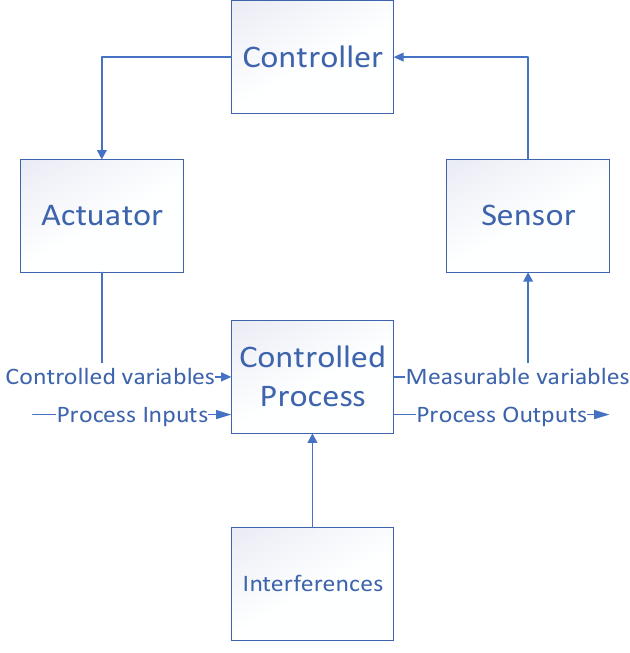
Figure 1. The control loop of the system deals with interferences.